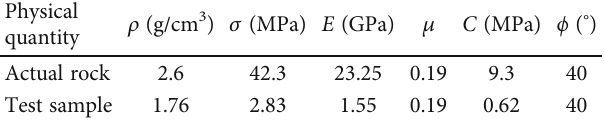
Table 2: Main physical and mechanical parameters of the simulation materials according to similarity